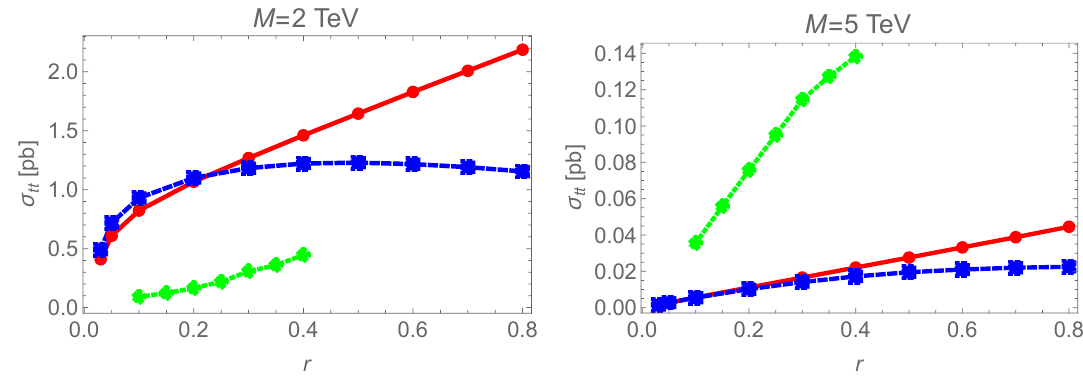
Figure 6 . pp → G ∗ → t ¯ t integrated cross-section as a function of the ratio r = Γ /M for the renor- malized on-shell mass M = 2 TeV (left panel) and 5 TeV (right panel) . The red solid lines correspond to the full propagator, the blue dashed lines to the BW propagator with on-shell parameters, and the green dotted line to the experimental 95% CL upper limit observed by the ATLAS collaboration